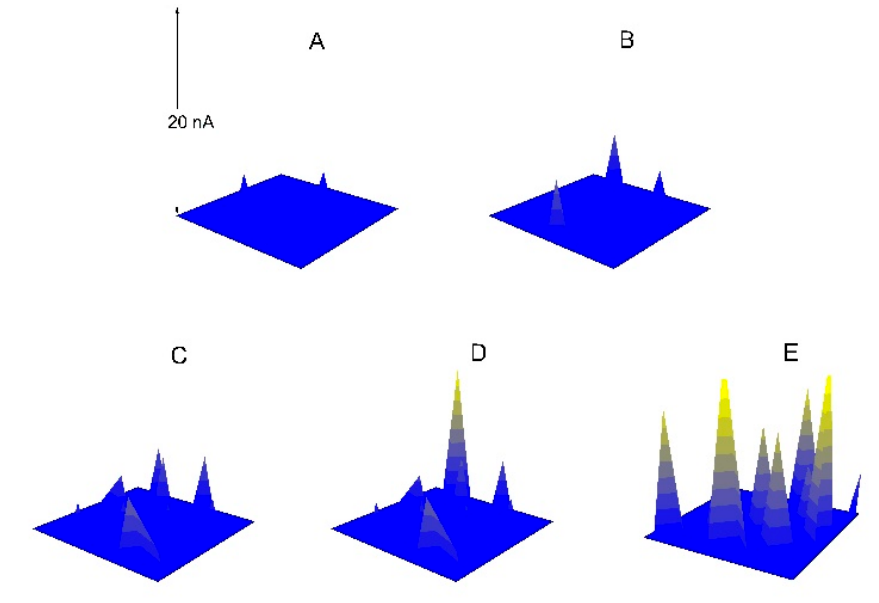
Figure 8. The SECM images of the X70 carbon steel electrode polarized at − 0.300 V ( E OCP = − 0.550 V) in 0.10 mol / L NaCl + 0.010 mol / L NaOH solution ( A ) 10 min; ( B ) 20 min; ( C ) 30 min; ( D ) 40 min; ( E ) 50 min.